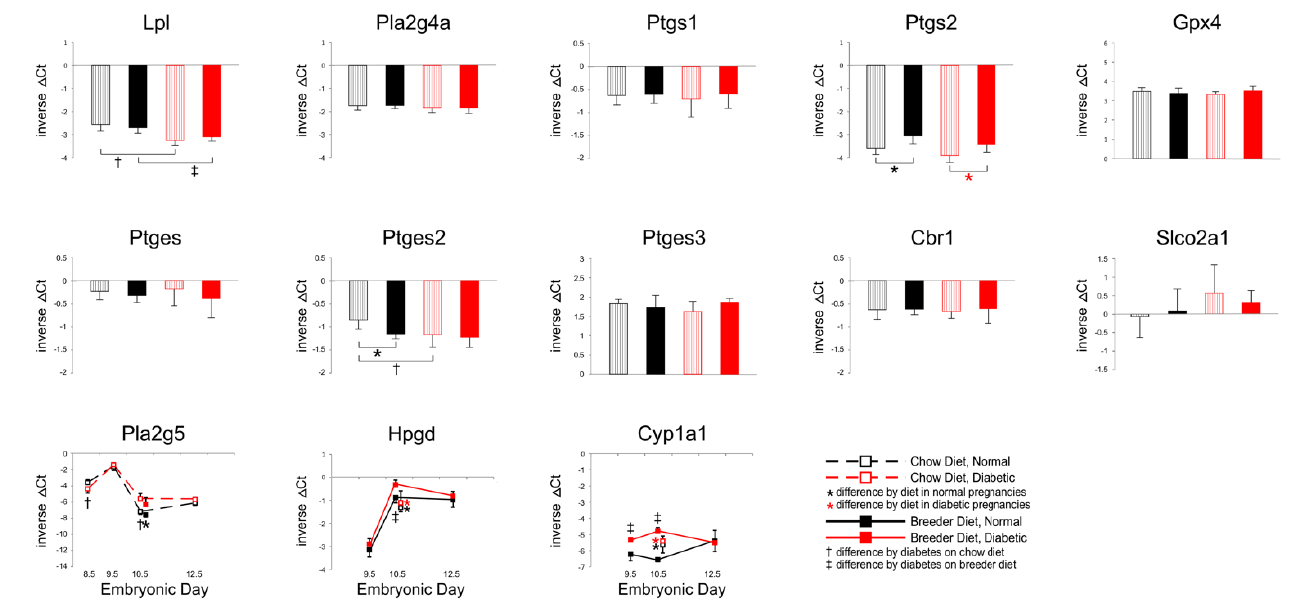
Figure 4. Expression of genes involved in prostaglandin synthesis and metabolism. Quantitative PCR measurements were performed at various time points, in dams that were either fed chow or breeder diet, and became diabetic in the week before, or were normoglycemic at the time of mating. Data in bar diagrams were obtained from placentae isolated at E10.5.